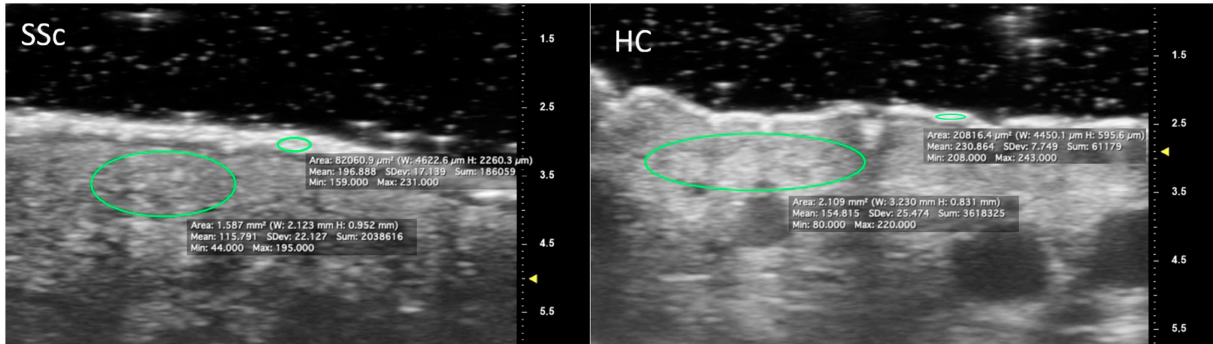
Figure 3. Measurement of epidermal and dermal grayscale values using ROIs positioned at the intermediate phalanx of the second finger. Note the reduction in the mean grayscale value in the SSc patient compared to the control subject in the epidermal and dermal areas.